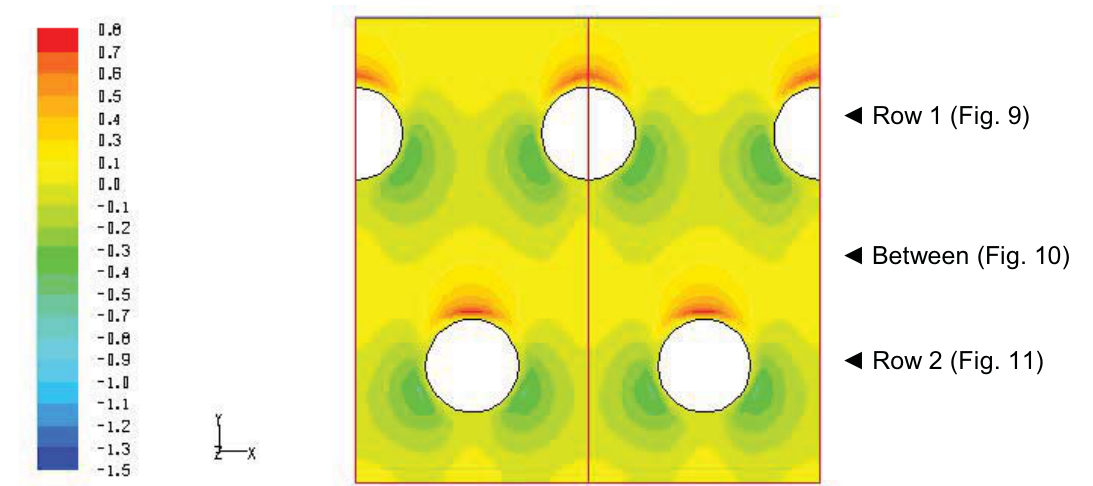
Figure 8: Radial velocity component (z) upright to the contact plane